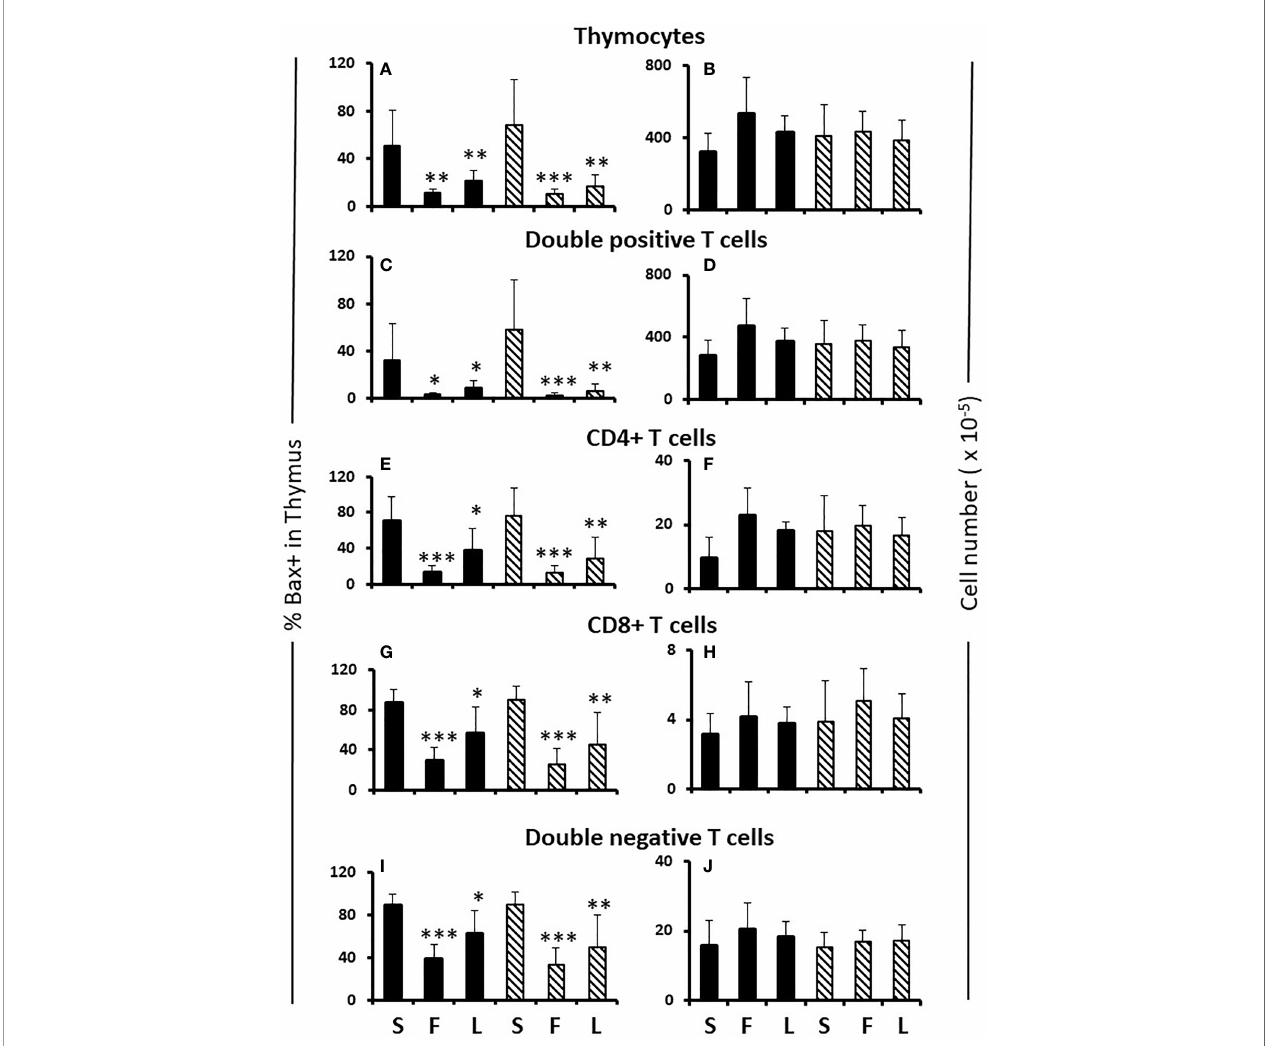
FIGURE 5 | Effect of fl utamide and letrozole on the percentage of cells expressing Bax and the number of cells in the thymus of pups. FCG Mouse pups were treated between days 1 and 7 postpartum before collection of thymi. Data are presented as a proportion of gated lymphocytes. The means ± SD are derived from 6 males and 8 females in the sesame oil control group, 7 males and 13 females in the fl utamide group and 11 males and 7 females in the letrozole group. Males include both XYM and XXM (solid bars) and females include both XXF and XYF (cross-hatched bars). S, sesame oil control; F, fl utamide; L, letrozole. Different from same sex control *p < 0.05; **p < 0.01; ***p <